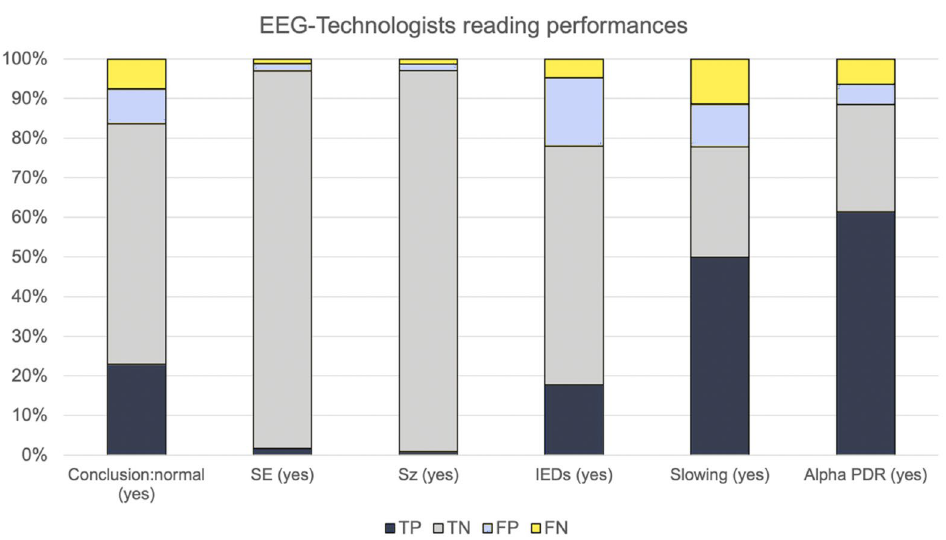
Figure 1. Percentages of true positives (in dark green; EEG patterns coded “yes” by both EEG technologists and neurophysiologists), true negatives (in light green; EEG patterns coded “no” by both EEG technologists and neurophysiologists), false positives (in orange; exams coded “yes” by EEG technologists and “no” by neurophysiologists), and false negatives (in red; exams coded “no” by EEG technologists and “yes” by neurophysiologists). FN False negative, FP false positive, TP true positive, TN true negative, IEDS interictal epileptiform discharges, PDR posterior dominant rhythm, SE status epilepticus, Sz